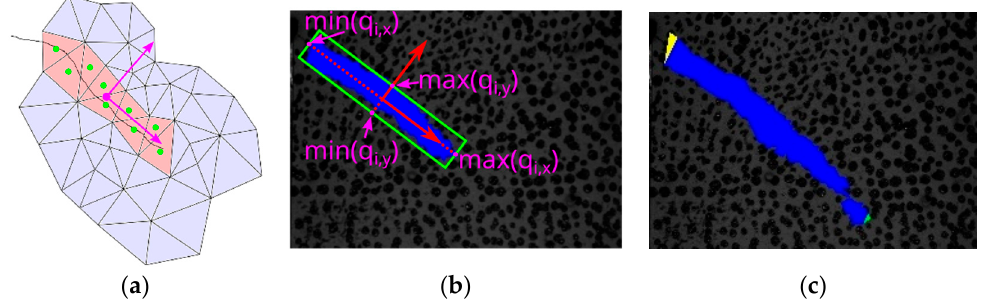
Figure 8. ( a ) Connected components of the deformed triangles in red, of which the center points are colored green, the mean and the principal directions magenta; ( b ) rotated bounding box computed using the principal component analysis (PCA); ( c ) crack tip detection by means of PCA. The yellow triangle is detected as a mesh boundary triangle, the green triangle shows the detected crack